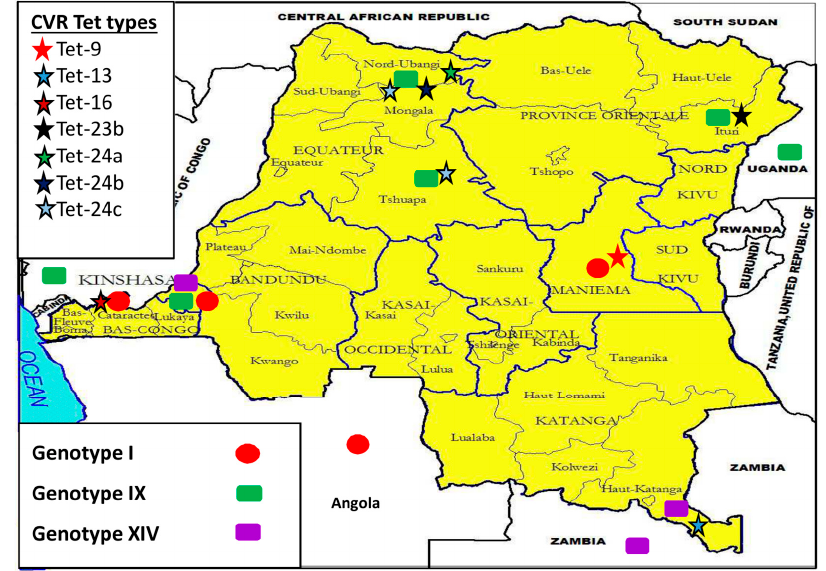
Figure 3. Provincial localization of revealed p72 genotypes and their corresponding central hypervariable region (CVR) tet-types within the DRC, as well as some historical African swine fever virus (ASFV) genotypes from neighboring countries.